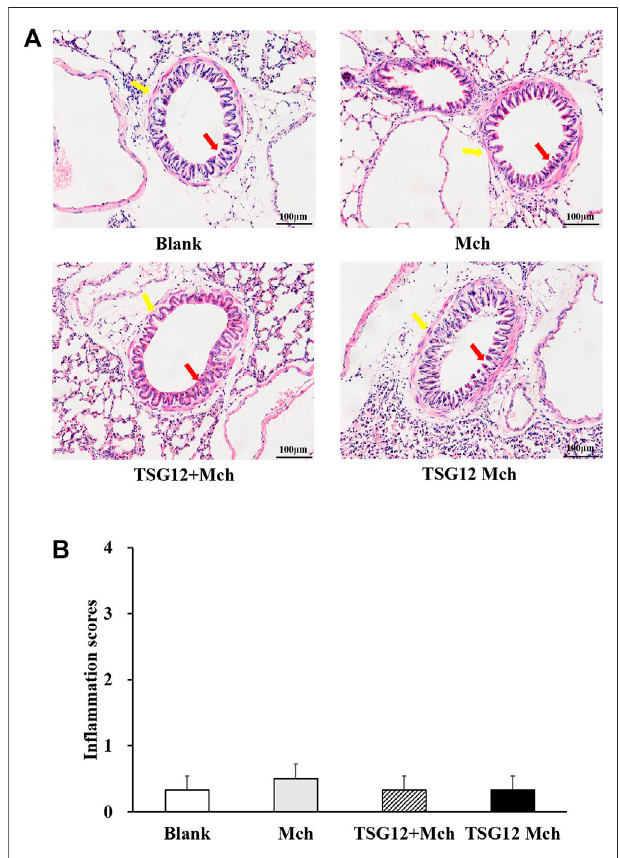
FIGURE3| Histopathological lung changes among differentgroups. (A) In the blank group, the bronchiolar structure (red arrow) was clear and there was no in fl ammatory cell in fi ltration around the bronchiolar (blue arrow). In the Mch group, TSG12 +Mch group,and TSG12 Mch group, therewere no signi fi cant changes compared with the blank group. (B) In fl ammation scores among different groups. Data werepresented asthe mean ±SEM, N =6, P ＜ 0.05 was considered statistically signi fi cant. Abbreviations: Mch, methacholine; SEM, standard error of